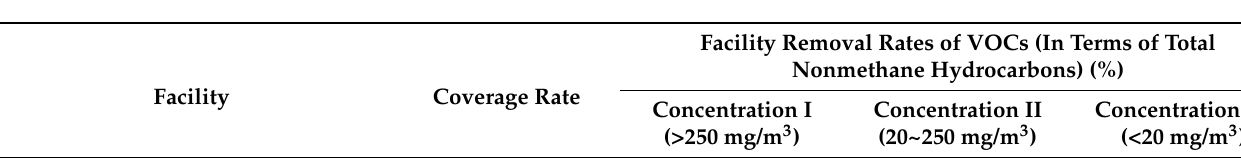
Table 4. VOC removal rates by common compliant and combined processes in the pesticide manufac- turing industry.